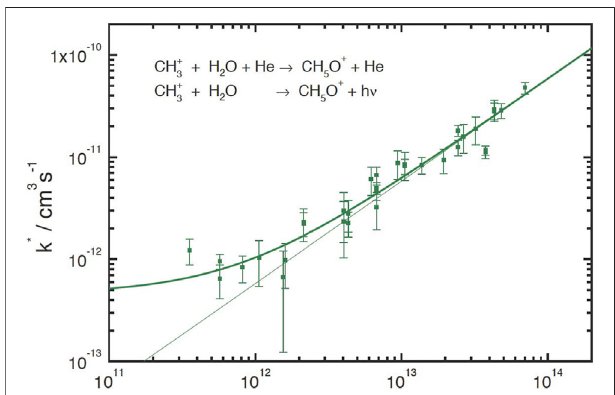
FIGURE 1 | Dependence of the effective rate coef fi cient for CH 3+ + H 2 O associationasafunctionoftheHenumberdensity.Theiontrap wasoperated at 20 K. The average H 2 O density was 8 × 10 7 cm − 3 . The measured values have been approximated by the function k * (cid:2) k 3b [He] + k ra which shows curvature above the ternary regime and leads to an approximate value for the radiative association rate coef fi cient of k ra (cid:2) 5 × 10 − 13 cm 3 s − 1 . The thin linear line simulates the pure ternary regime. Permission requested to reproduce Figure 3 of Luca et al. (2002) as printed originally by MATFYZPRESS (Sokolovská 49/83, 186 00 Praha 8-Karlín, Czechia) in the WDS ’ 02 Proceedings of Contributed Papers, PART II, 294 – 300,